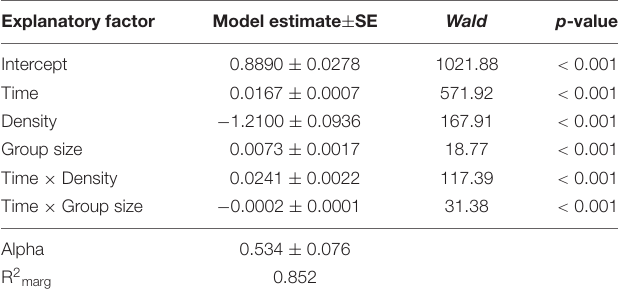
Supplementary Figure S3 , Supplementary Table S3 , Q-Q plot Supplementary Figure S2D